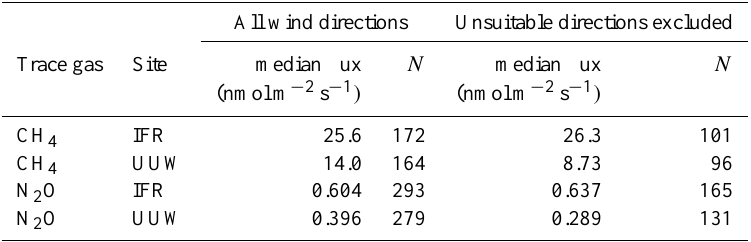
Table 2. Medians of nocturnal fluxes computed with the NSR method, as well the number of nights ( N ) contributing to the median, for two wind-direction selections: all included or unsuitable ones excluded. Directions are considered unsuitable for the IFR site when the dryland area is upwind, and unsuitable for the UUW site when either of two neighbouring irrigated circles is upwind. See text for specification of the directional